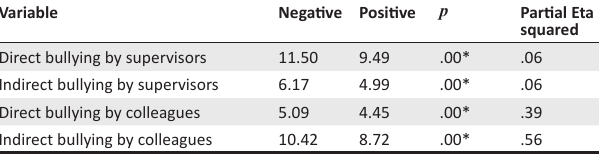
TABLE 11: Analysis of variance – differences in workplace bullying based on diversity